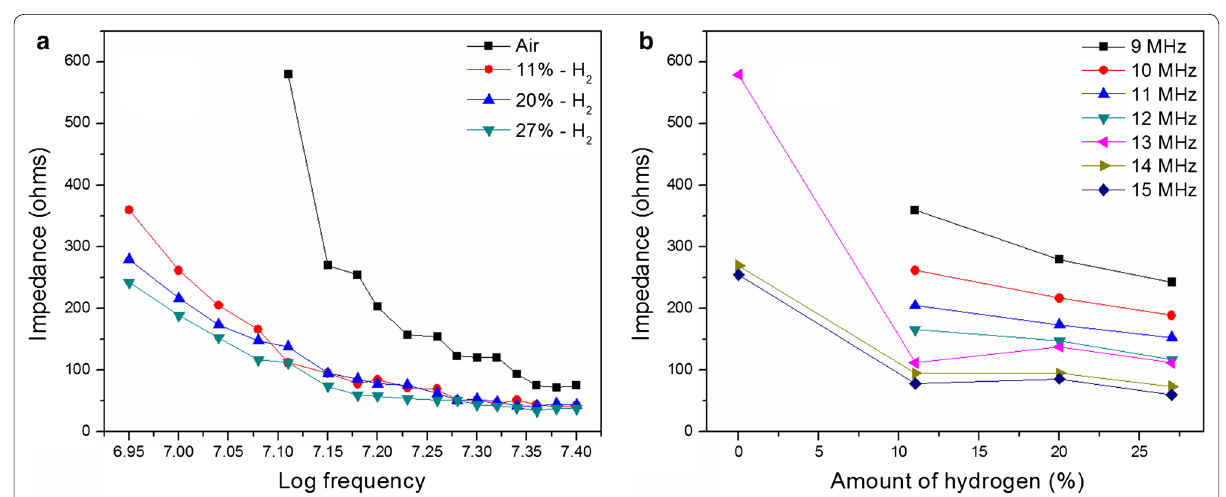
Fig. 14 a Impedance vs frequency and b impedance vs H 2 percentage in 9–15 MHz frequency domain for Pd incorporated PAni